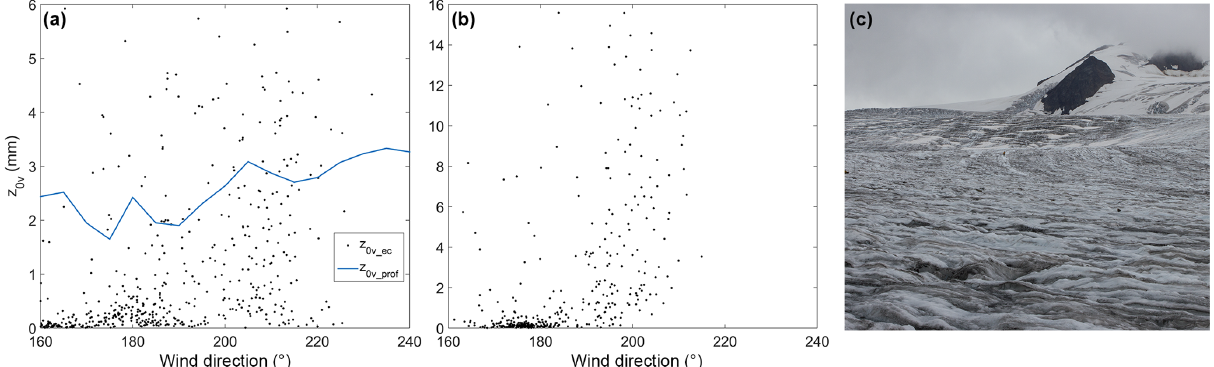
Figure 12. The dependence of momentum roughness length values on wind direction for (a) z 0v_ec (filtered 30min values) and z 0v_prof at CG16-1, and (b) z 0v_ec at CG15-2 (lidar data were not available for CG15-2 during this period). (c) Elongated roughness features on Conrad Glacier, looking south from CG15-1 in July 2015. The meltwater channels had approximate dimensions of 0.5–1m in width and 0.1–0.2m in depth, with substantial variability.